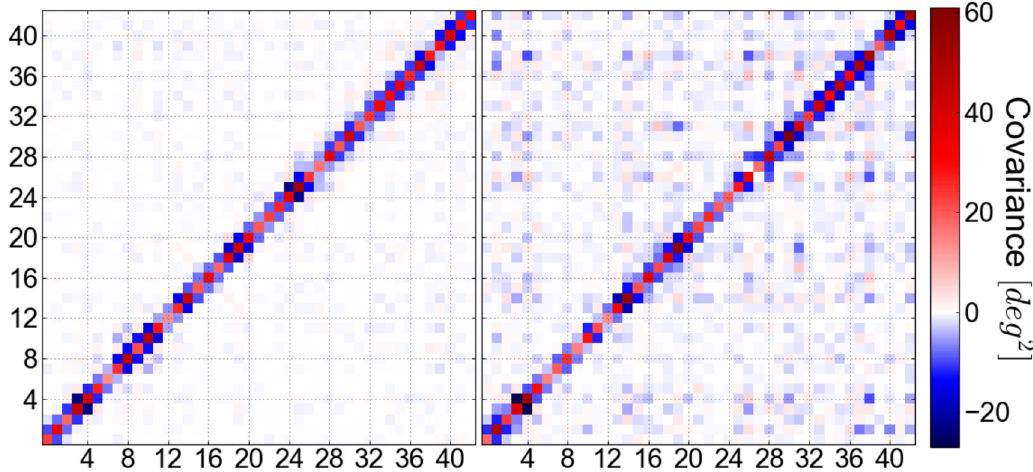
Fig 1. Covariance matrix of the twist fluctuations obtained for the central 43 base-pair steps during MD-simulations (at- sequence). In the unrestrained case (left panel), coupling exists only between nearest neighbor sites. Upon global unwinding (right panel, σ = 0.067), also distant sites become coupled to a significant extent.